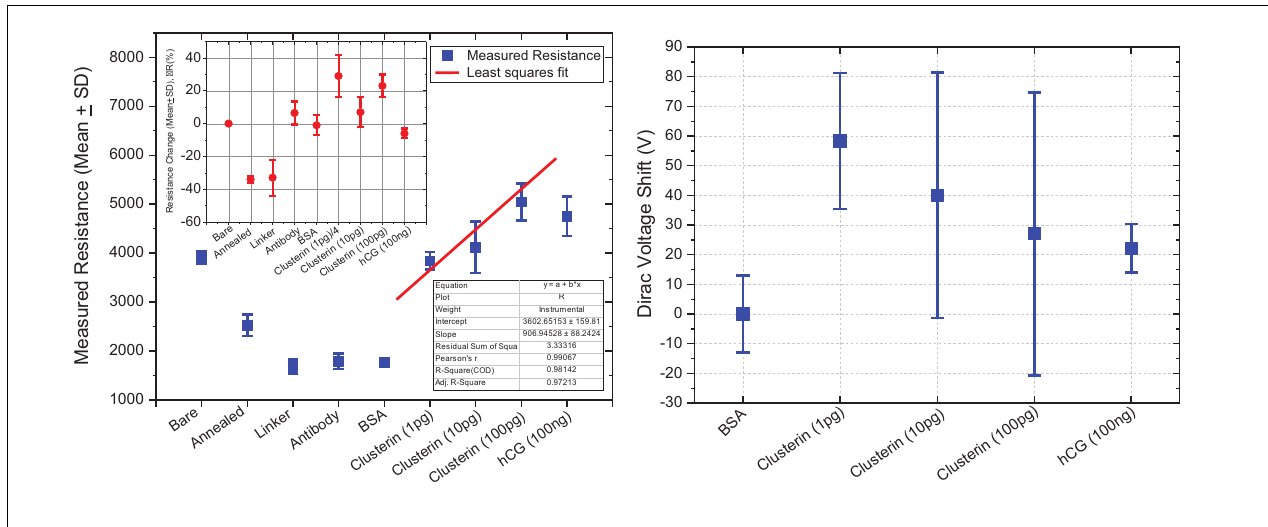
FIGURE 11 | Measured resistance (in ohms, Mean ± SD) for each functionalization stage with a log-linear least squares fit (solid line, effectively a partial Hill–Langmuir equation fit) to the measured data from 1 to 100 pg/mL of Clusterin concentration and the fit parameters showing adjusted r 2 ˜ 0.98 (left) . The inset shows corresponding percentage resistance change relative to the previous stage (with bare stage being 0% by definition). Note, the data in the inset for resistance change at 1 pg/mL Clusterin is reduced by a factor of 4 for clarity and analyte concentrations are in units of g/mL. Corresponding back-gated measurements of Dirac voltage shifts normalized with respect to the BSA stage, demonstrating a first-time observation of a characteristic response curve for the GFET biosensors (right) . voltage shift has been demonstrated for Clusterin detection using CVD single layer GFETs that may also broadly be expected for the detection of other molecular species. Table 3 shows a variety of biosensing platforms and detection techniques in comparison with our results reported in Table 4 using 4-PER and Dirac voltage shift techniques.